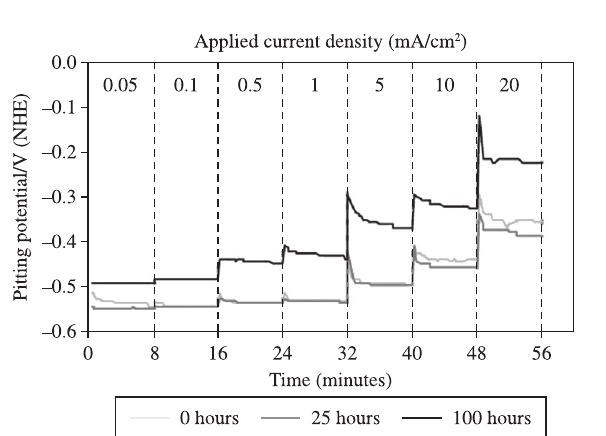
Figure 8. a) Surface of sample with powder of 70 hours milling time before corrosion test; b) surface of sample with powder of 70 hours milling time after corrosion test in 1M NaCl